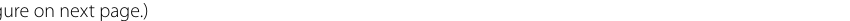
30) and vehicle‑treated DiI‑positive neurons (open circles; = 0.50; =